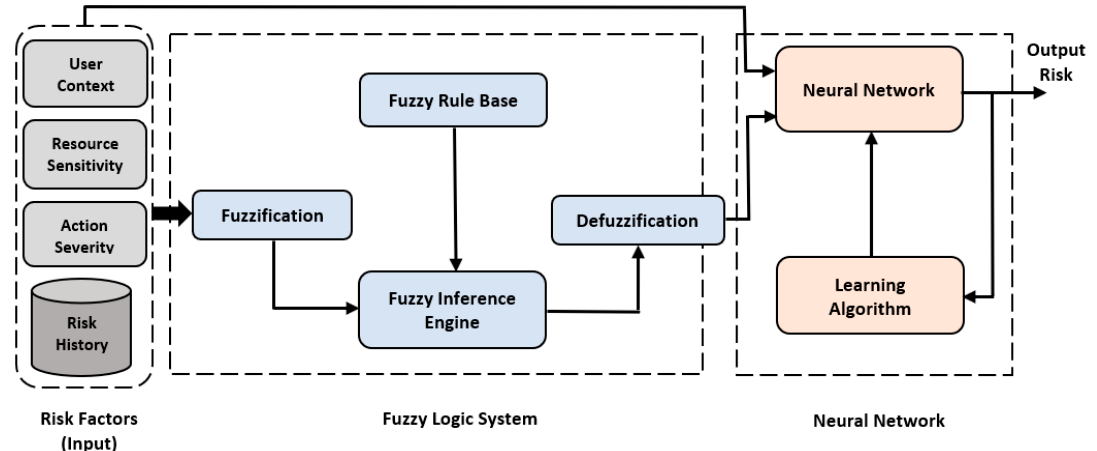
Figure 2. Structure of the Proposed NFS model.